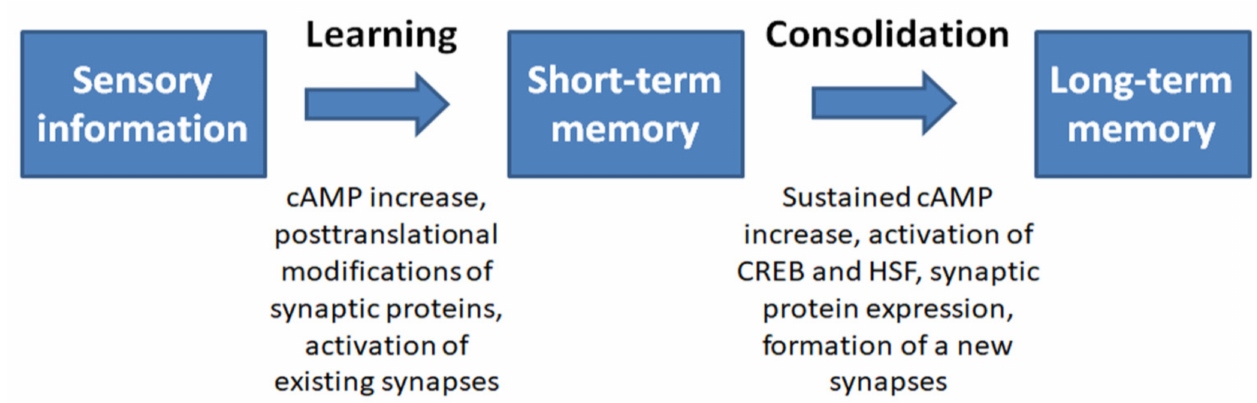
Figure 2. Summary of the sequence of events during memory formation